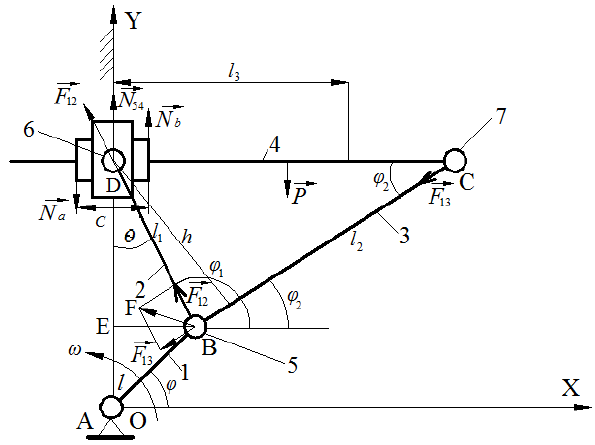
Figure 4. Diagram of the mechanism of vibrating table indicating the forces exerted on kinematic